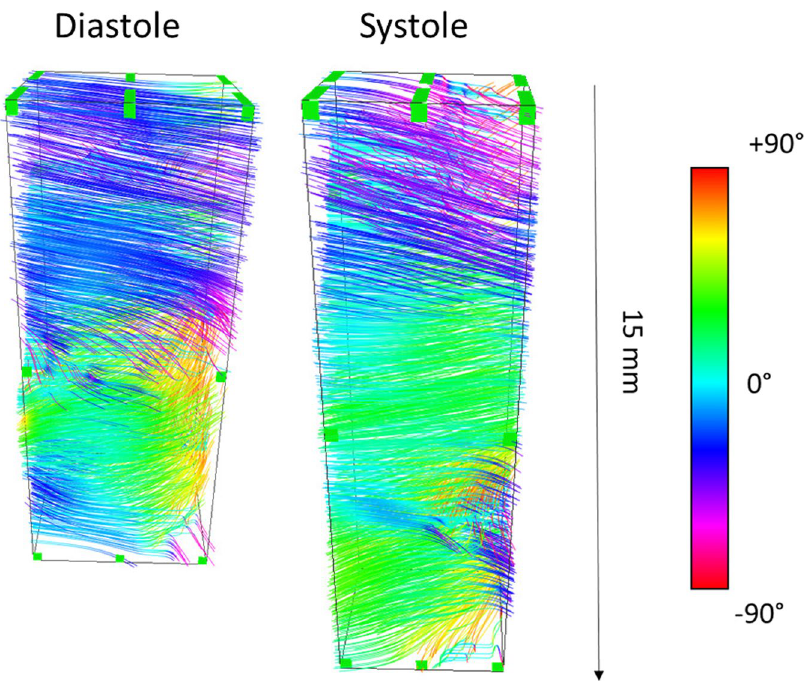
Figure 6. Transthoracic imaging of myocardial fiber orientation in the human heart. The fiber orientations of the antero-septal LV wall is shown in end-diastole and